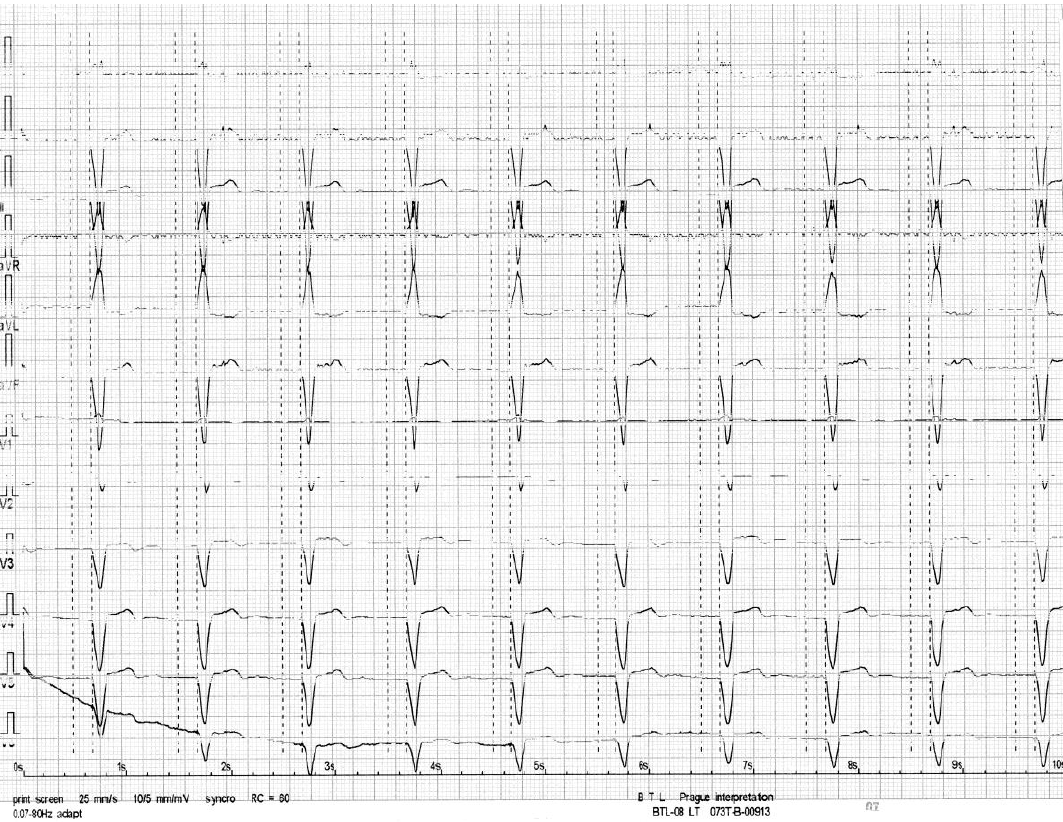
Figure 3. Electrocardiogram showing the stimulation of the bicameral pacemaker after definitive implanting.